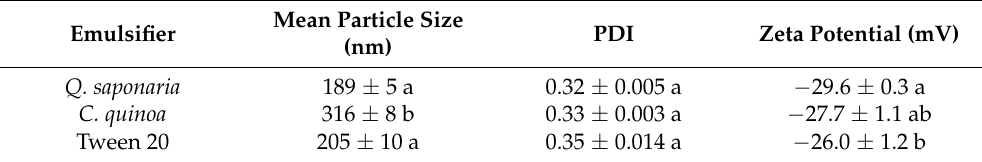
Table 2. Mean particle size, zeta potential and polydispersity index (PDI) of emulsions prepared with Q. saponaria or C. quinoa extracts as